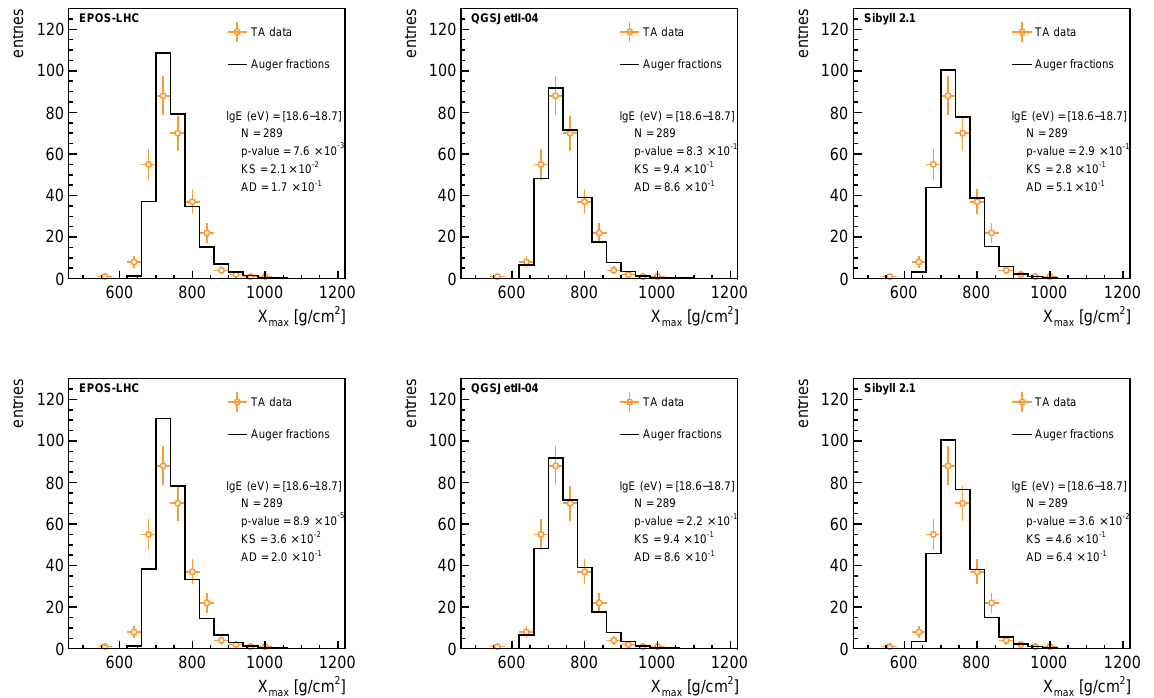
→ TA ( eV ) = [18.6–18.7] max in the energy interval lg E